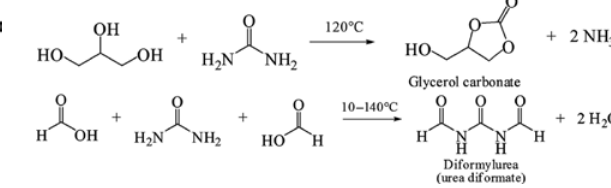
Figure 3: Chemical reaction between glycerin and urea (upper reac- tion) and formic acid and urea (lower